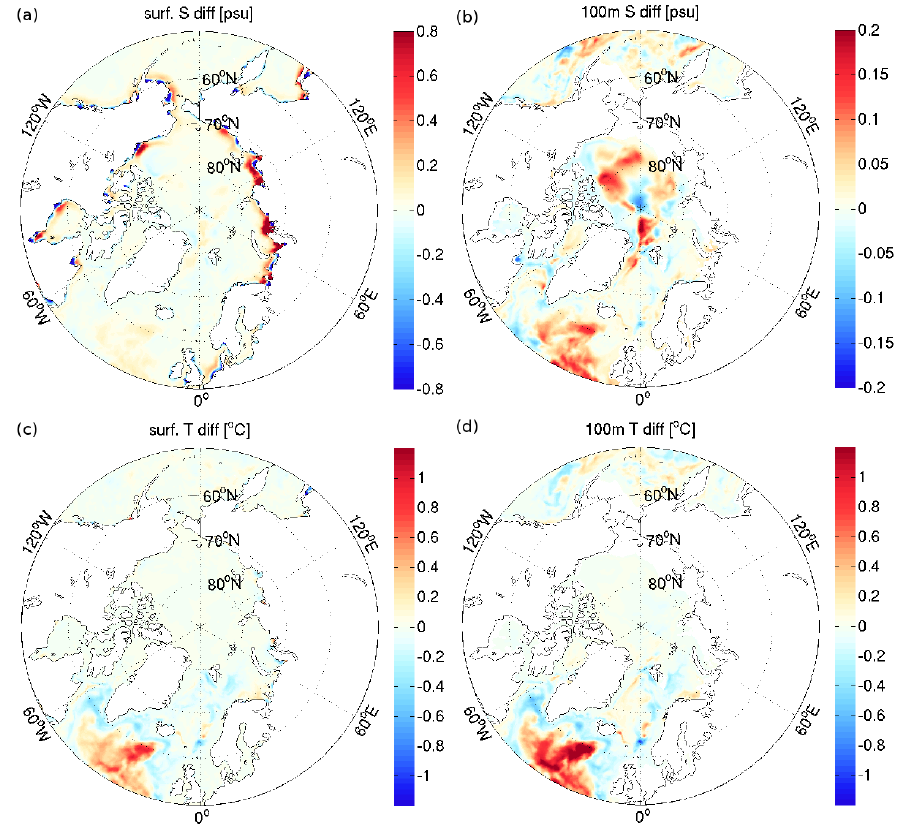
Fig. 19. The salinity difference between runs with river runoff distributed over 400km and 100km (the latter minus the former) for (a) surface Fig. 119. The salinity difference between runs with river runoff dis- and (b) 100m depth. (c) , (d) The same as (a) , (b) , respectively, but for temperature. The results are the last 10yr mean in 60yr tributed over 400 km and 100 km (the latter minus former) for (a) surface and (b) 100 m depth. (c) , (d) The same as (a) , (b) , respec- tively, but for temperature. The results are the last 10 yr mean in 60 yr simulations.